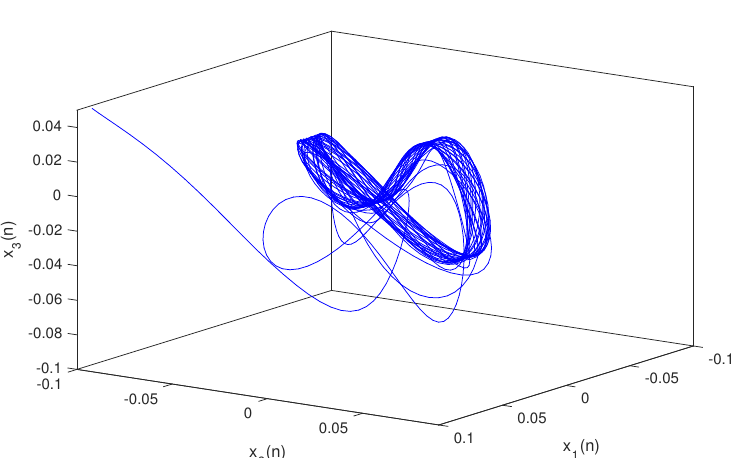
Figure 9. Discrete situation T = Z : x 1 ( n ) , x 2 ( n ) , x 3 ( n )